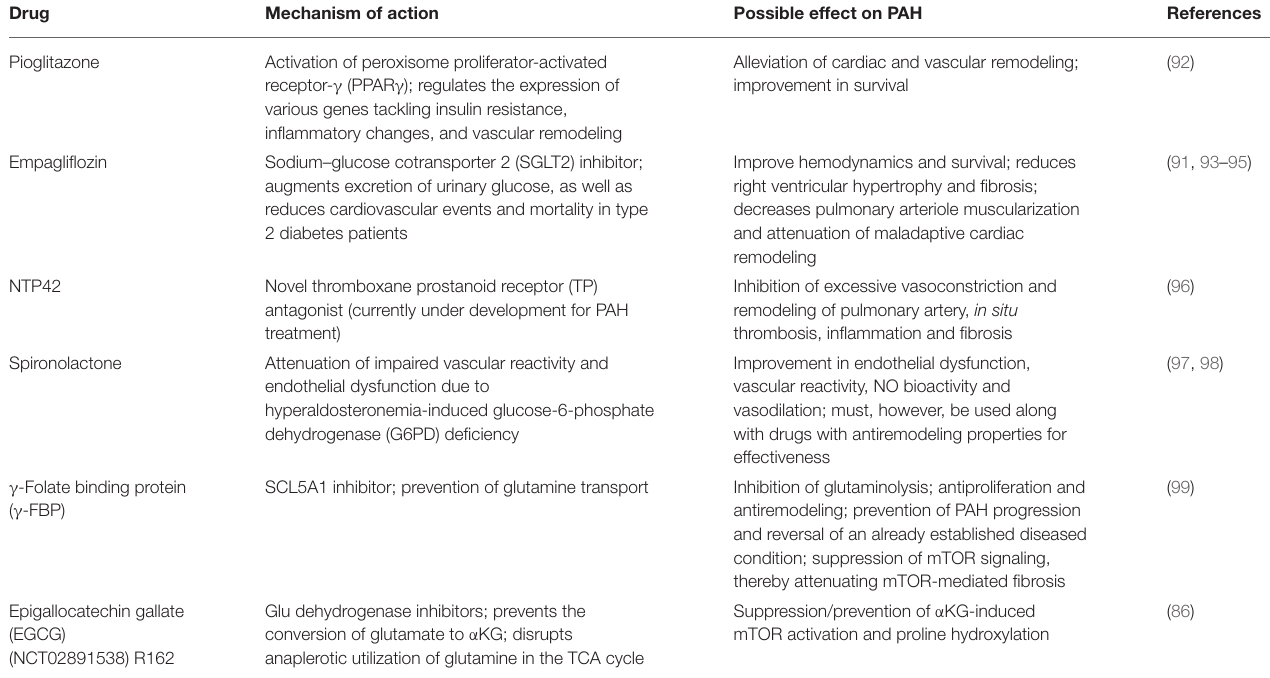
TABLE 3 | Potential repurposable drugs for PAH management.